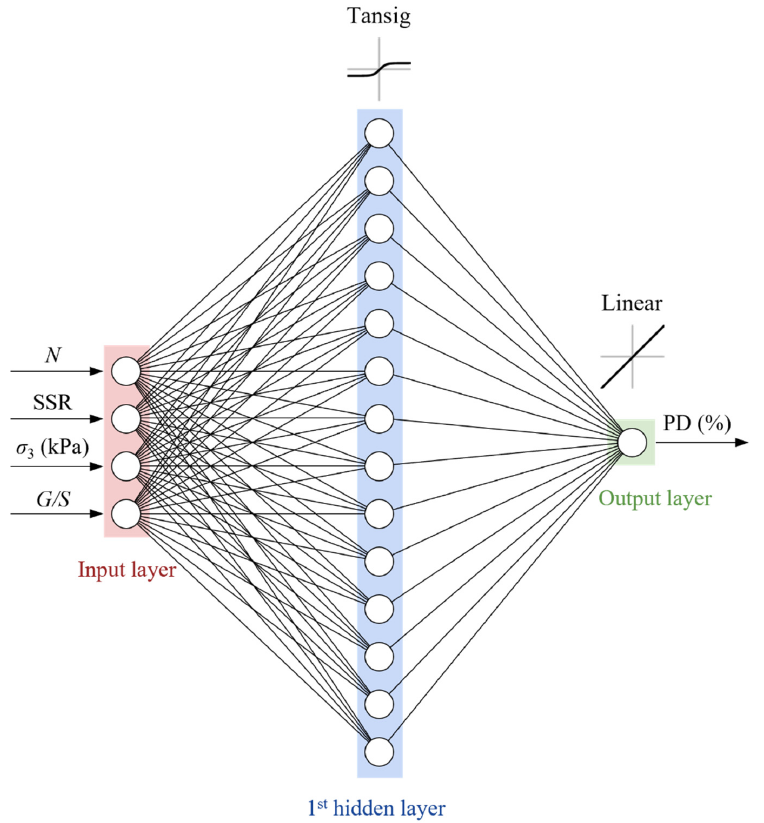
Figure 14. The ANN-based prediction model with the optimal network topology.